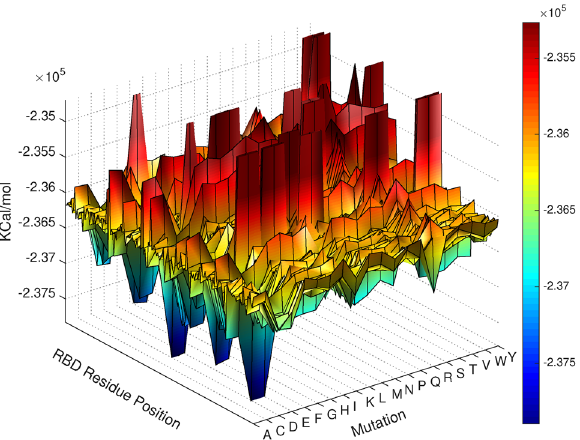
Figure 3. Mutation Landscape of the receptor-binding domain in SARS-CoV-2. Energy values are in kcal/mol and are computed by Eq. (1). Each x,y coordinate represents a mutation x at a position y. The z-values are the free energies of the mutated structures. Lower energies (blue) correspond to increased